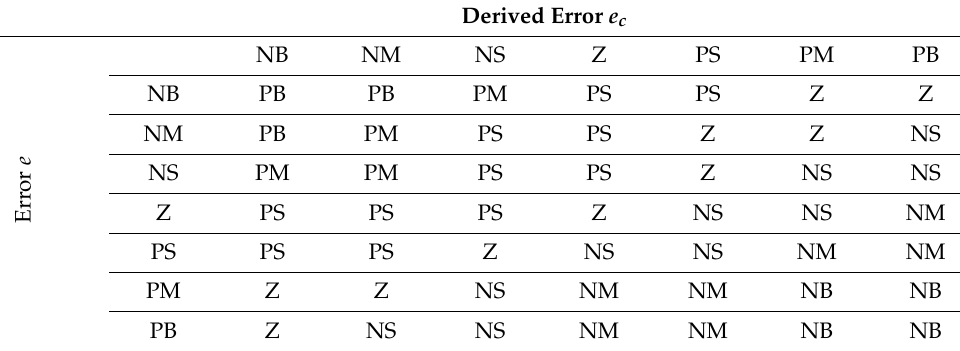
Table 3. Fuzzy rules for k i 1 .